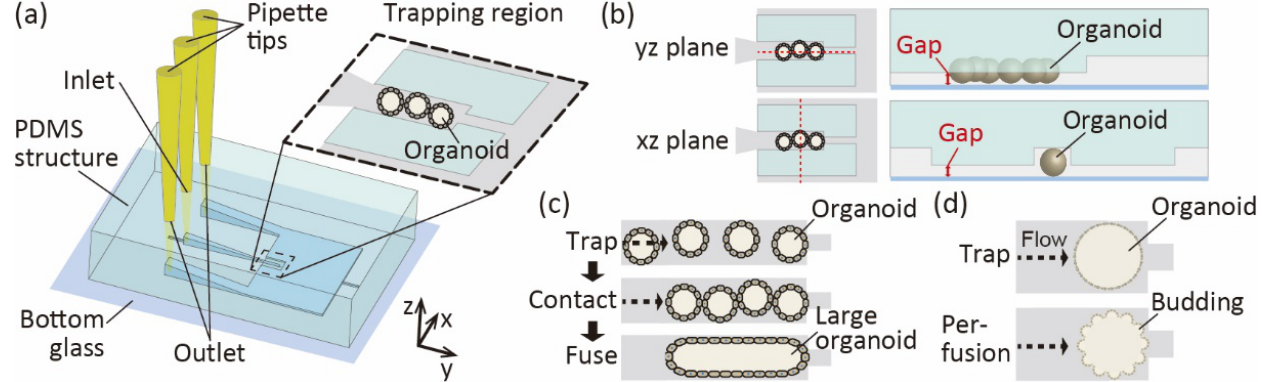
Figure 1. Conceptual illustration for manipulation of organoids using the proposed microfluidic device. ( a ) Microfluidic organoid-trapping device to trap and perfusion culture of organoids at its trapping region. ( b ) A top and side view of the trapping region. Red arrows indicate the wall gaps between the channel wall and the bottom surface. ( c ) Concept of organoid fusion in the trapping region. ( d ) Concept of applying fluidic stress to the organoid in the trapping region.